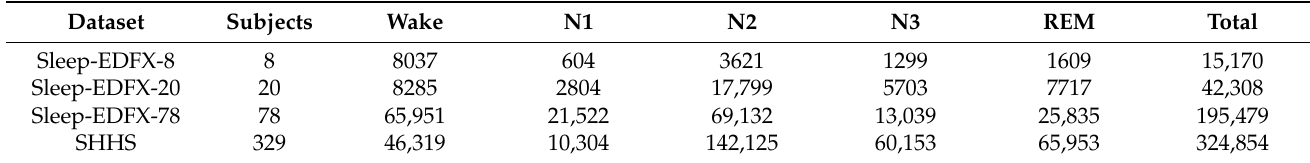
Table 1. Number of subjects and sleep stage epochs in Sleep-EDFX-8, Sleep-EDFX-20, Sleep-EDFX-78 and SHHS datasets.